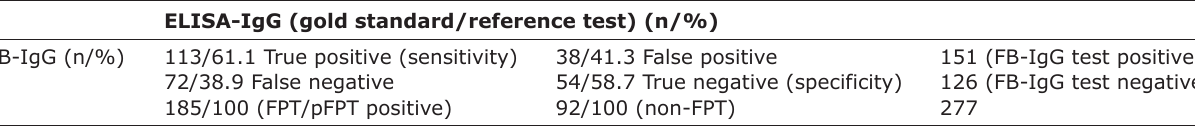
Table-2: Comparison of the classification between the FB-IgG and ELISA-IgG of the calves categorized by age and health status. ELISA-IgG (gold standard/reference test) (n/%) Age≤3 days, healthy FB-IgG (n/%) 47/79.7 True positive